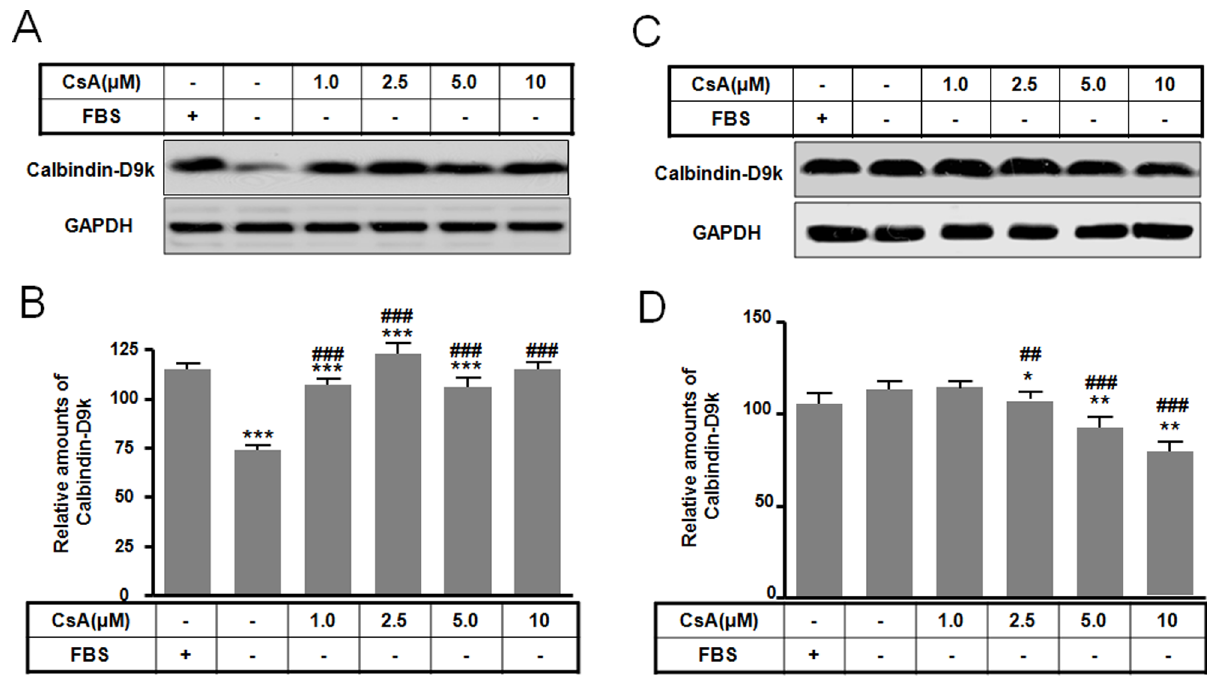
Figure 6. Effect of CsA-mediated autophagic and apoptotic death on calbindin-D9k levels. GH3 cells were incubated in DMEM with or without 10% fetal bovine serum in the presence or absence of CsA (0 to 10 m M) for 10 h. Calbindin-D9k levels for autophagy (A) and apoptosis (C) were determined by Western blotting and the relative amount of calbindin-D9k for autophagy (B) and apoptosis (D) was calculated as described in the Materials and Methods. * p , 0.05, ** p , 0.01, *** p , 0.001 vs. serum treatment. ## p , 0.01, ### p , 0.001 vs. no serum